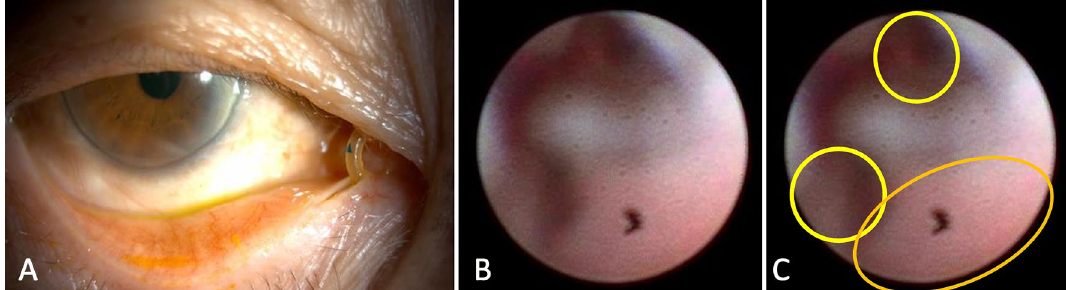
Figure 6. Complications associated with ENDI surgery. ( A ) Punctum slitting. The inferior punctum was stretched nasally caused by the traction of the tube through the nasolacrimal duct. ( B ) Endoscopic image of mucosal granulation in a nasolacrimal duct. Original image of a case complicated with reobstruction during tube placement. ( C ) Annotation for B. The two yellow circles indicate the space where the tubes were placed during the intubation. The orange oval indicates mucosal